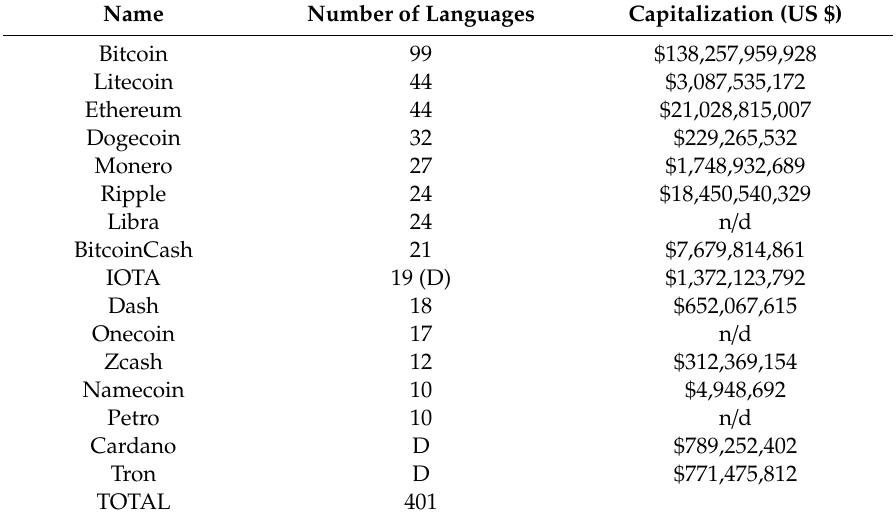
Table 2. Ranking of cryptocurrency articles with the largest number of language